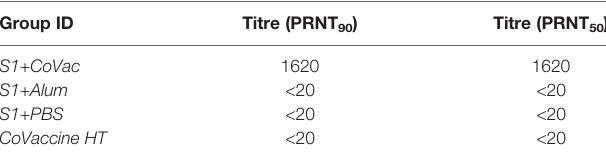
TABLE 1 | SARS-CoV-2 neutralization